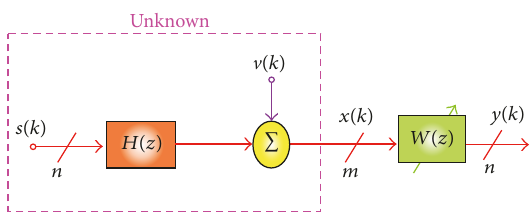
Figure 3: Block diagram of the basic BSS problem